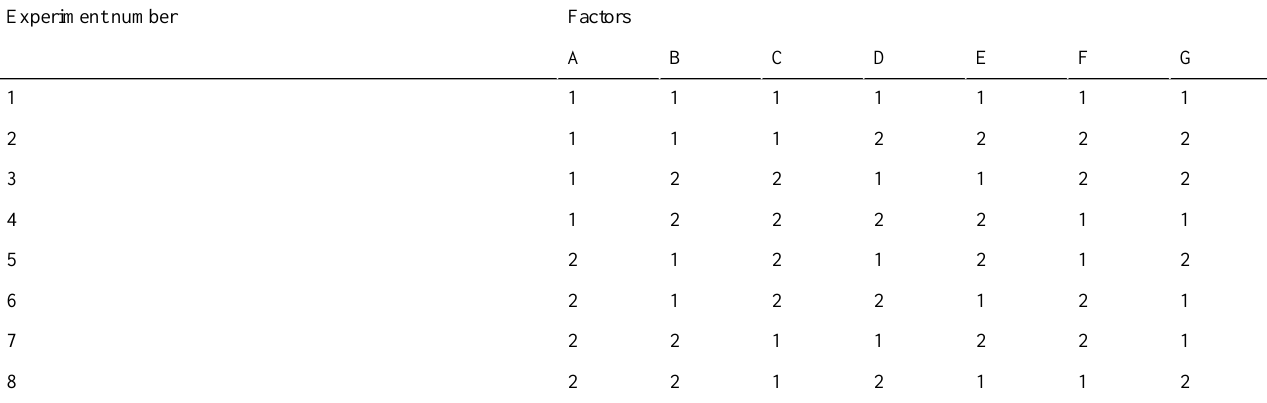
Table 1. A L8(27) orthogonal